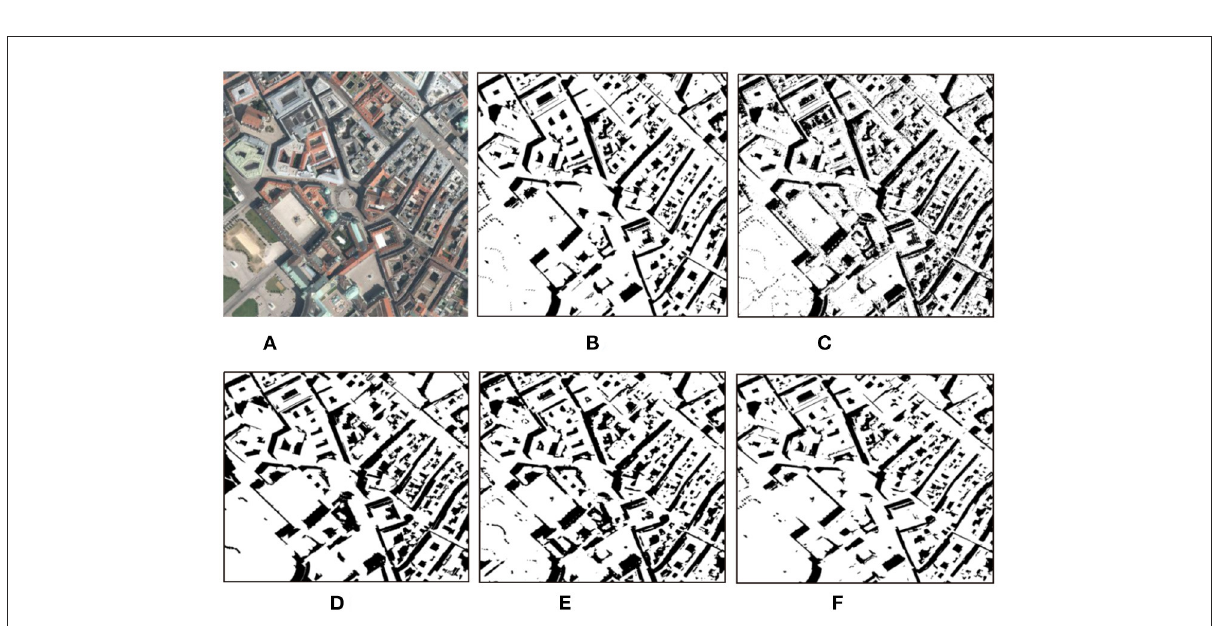
FIGURE12 Detection results with different methods on remote sensing images (Vienna). (A) Shadow image, (B) GT, (C) GSCA-Unet, (D) SAS, (E) DSAN, and (F) proposed.